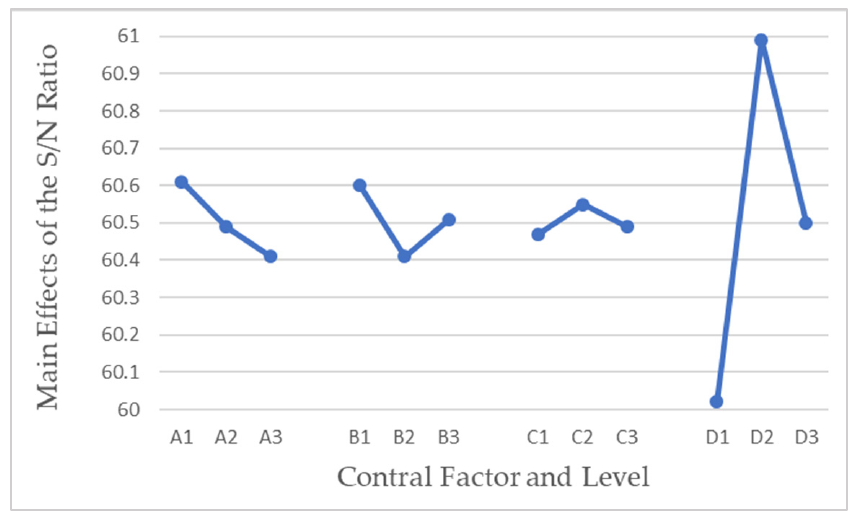
Figure 3. Main effects of S/N ratio for optimizing tensile strength. Table 3. Signal-to-noise ratio and ANOVA for optimization of tensile strength. S/N Ratio (dB) Factor